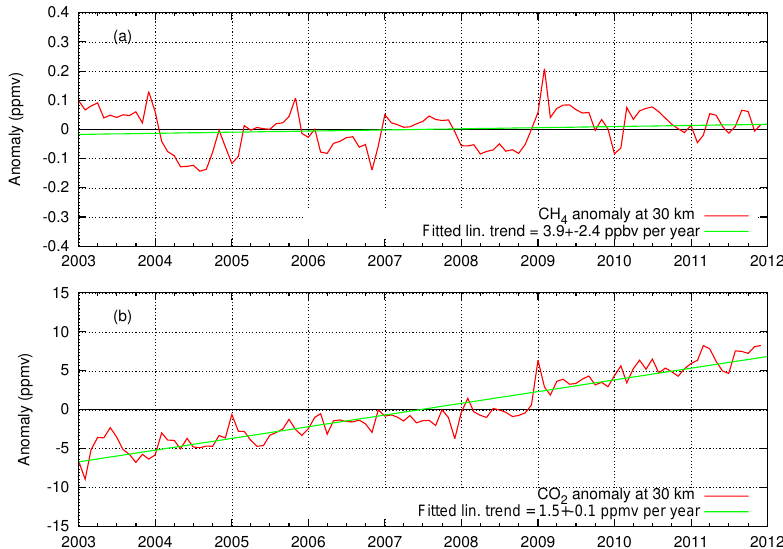
Figure 15. Time series of SCIAMACHY CH 4 (a) and CO 2 (b) VMR anomalies at 30km. Red lines show the daily averaged data. Green lines show the linear